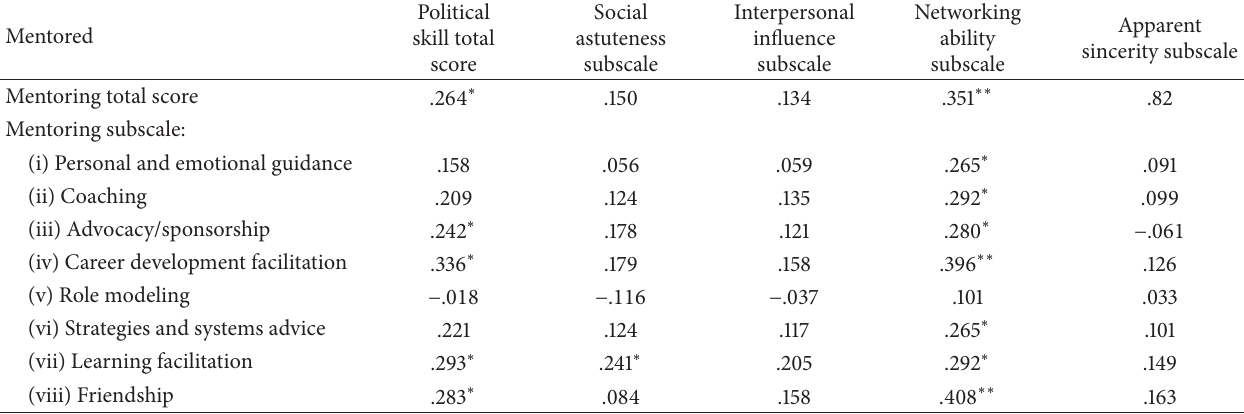
Table 5: Correlations between political skill and mentoring scores using Spearman’s Rho ( 𝑁 = 74 ). Mentored Mentoring total